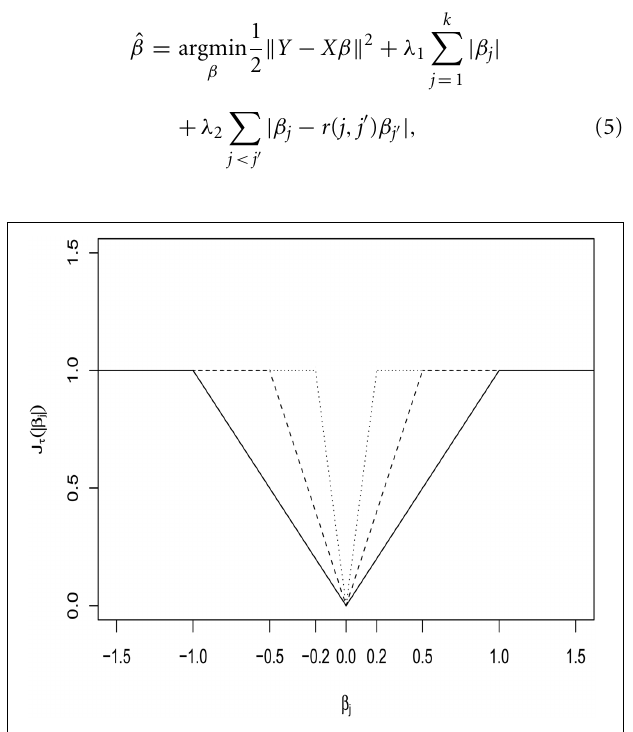
FIGURE 1 | Truncated L 1 -penalty (TLP) function J τ ( | β j | ) with τ = 0 . 2, 0.5, and 1 (as solid, dashed and dotted lines,